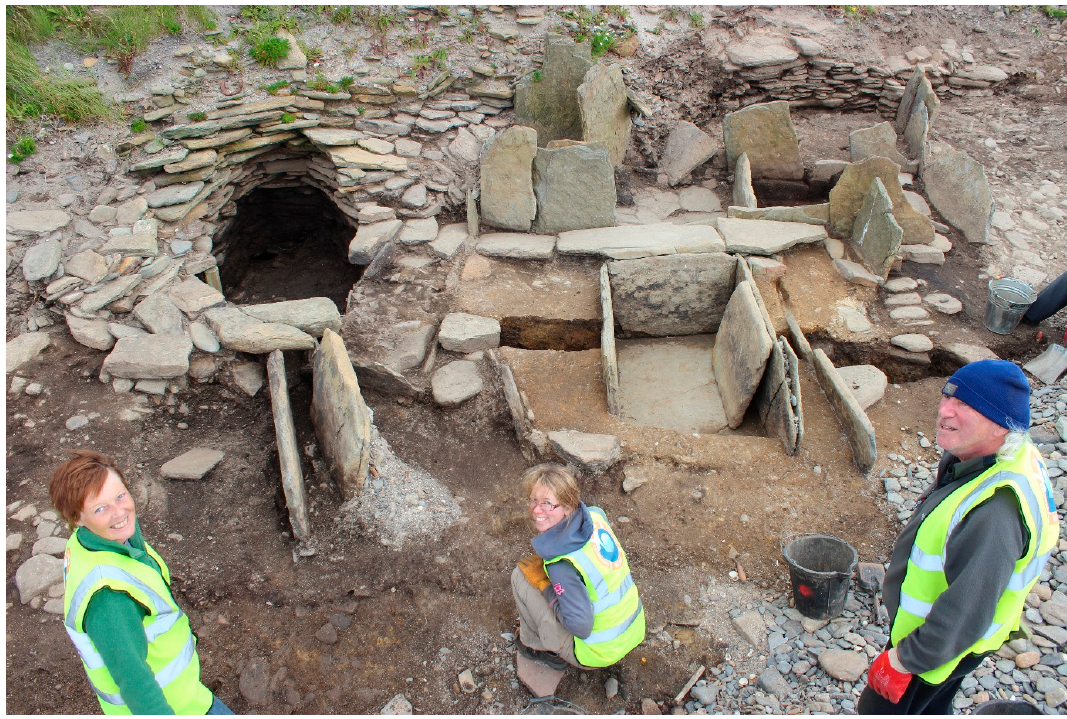
Figure 5. Some of the team on site during the excavation of the burnt mound of the beach at Meur, July 2014.